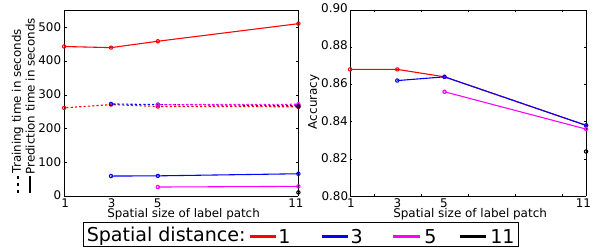
Figure 8. Influence on computation time and accuracy by structured